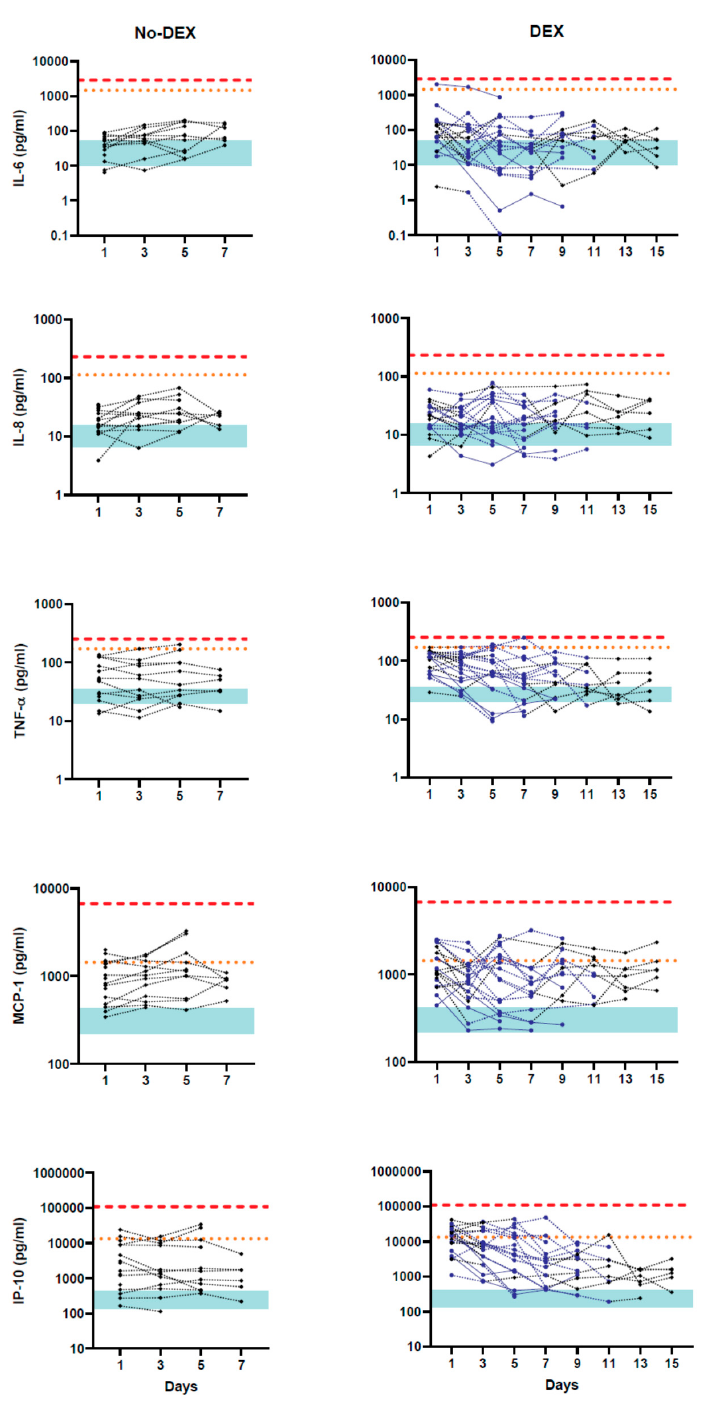
Figure 1. Cytokine concentrations in COVID-19 patients after hospitalization. Circulating cytokine concentrations for each patient are shown on a logarithmic scale. The left panel shows patients in the no-dexamethasone treatment (DEX) group. In the DEX group, data points and lines when the patient is on dexamethasone are shown in blue, while those before and after treatment are shown in black. Four patients were on dexamethasone treatment throughout the observation period, and their data points are connected with a solid blue line. The red dashed line shows the lower 95% confidence limit of influenza (CS) patient values, while the dotted line represents the lower limit for burn injury patients. Upper and lower confidence limits for the control group are shown in turquoise shaded areas.